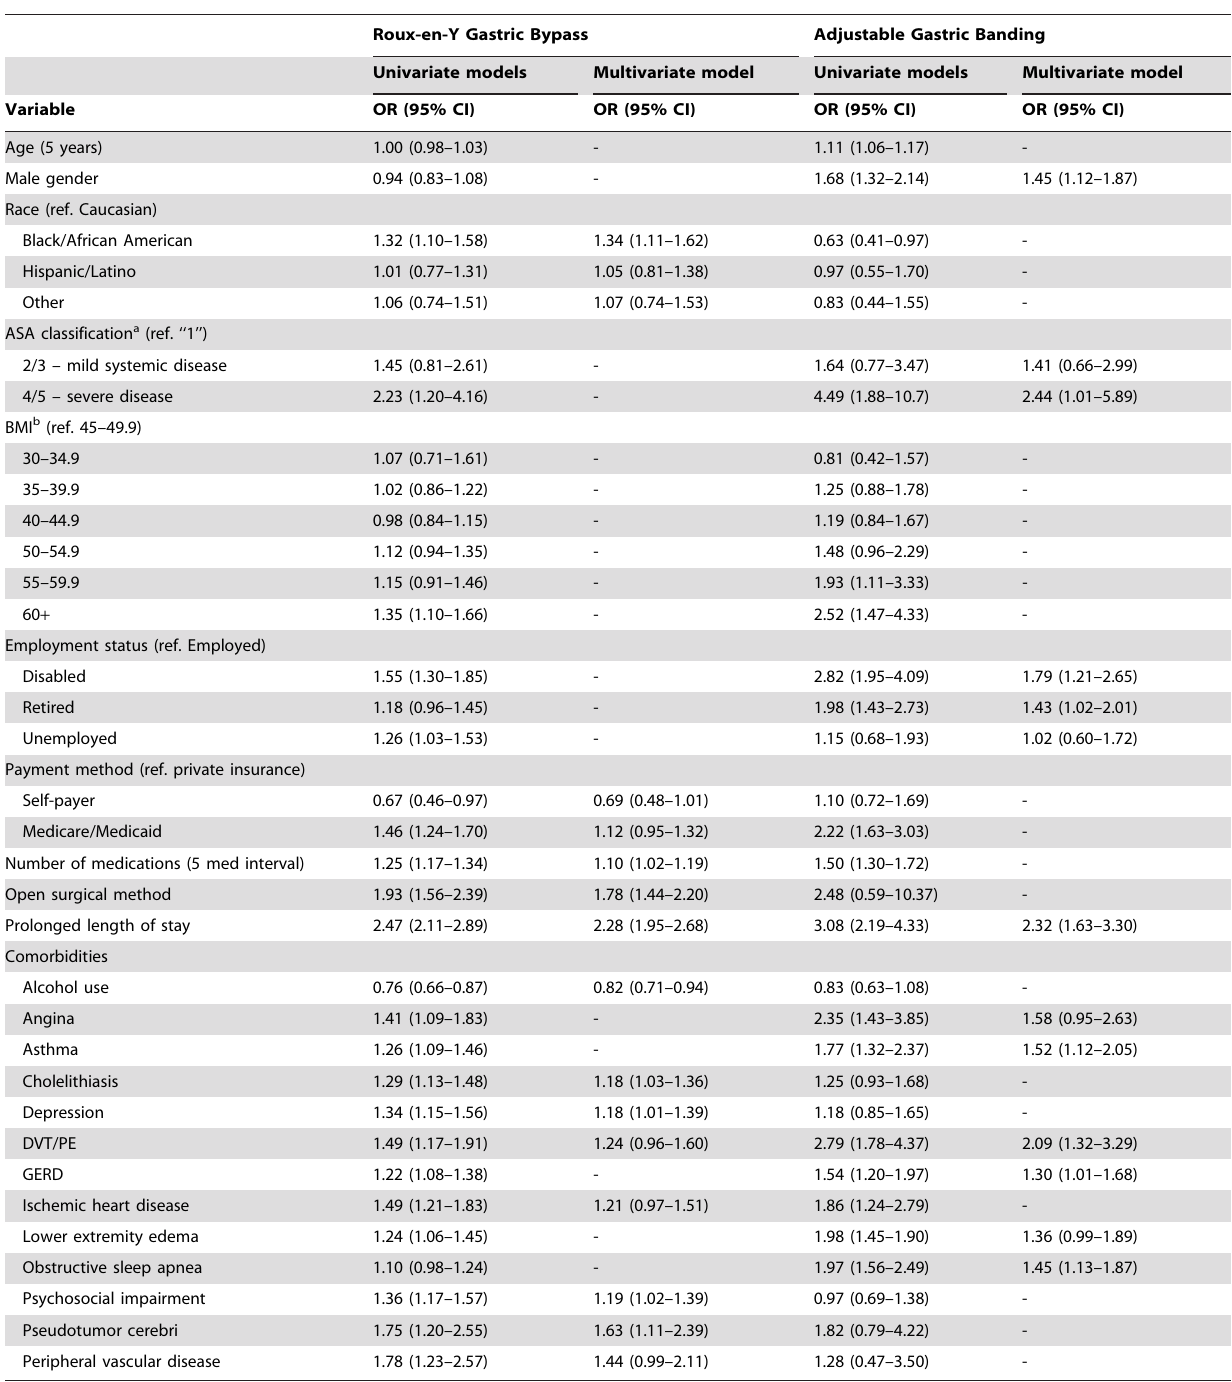
Table 4. Univariate and Multivariate Models of Risk Factors for 30-Day All-Cause Hospital Readmission by